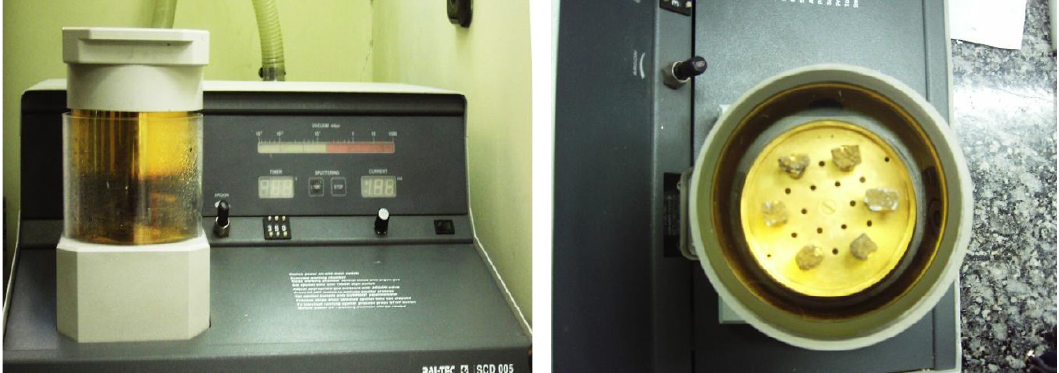
Fig. 2: Sputter coating Figure 2 : Sputter coating unit.